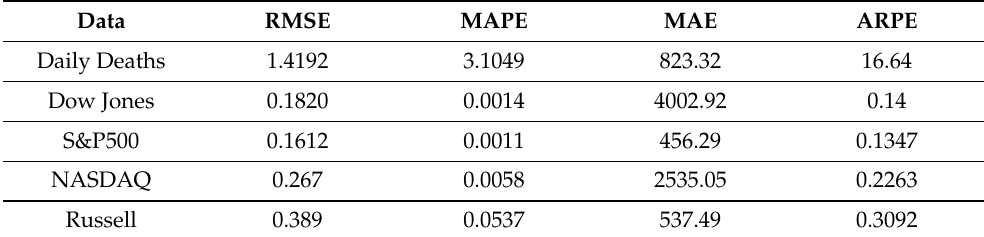
Table 14. Results from system of Γ ( a , b ) OU model. The results reported are the best results from modeling a combination of U.S.A. COVID-19 deaths with the stock market data.